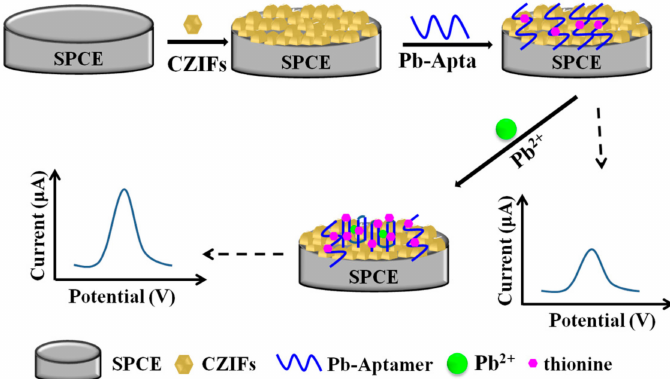
Scheme 1. Presentation diagram of the preparation process for the aptasensor and Pb 2+ detection.